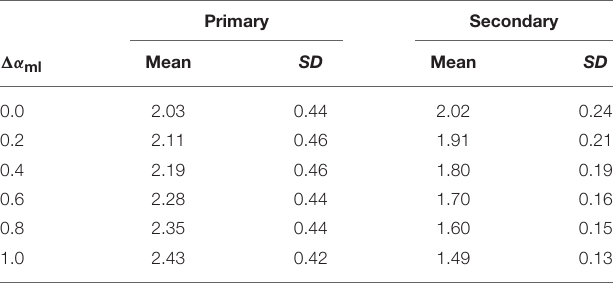
TABLE 3 | As in Table 2 , but imposing the constraints of common age, and common initial Z and Y for the binary components. Primary Secondary 1α